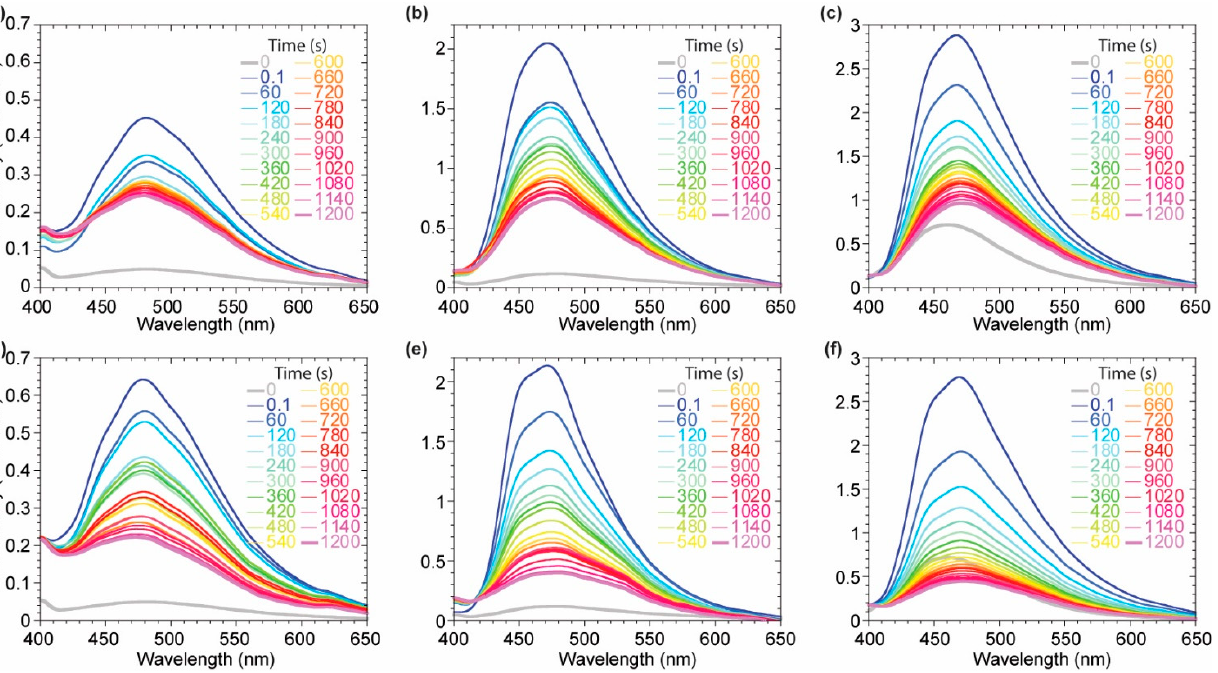
Figure 4. Kinetic experiments in DOPC ( a – c ) and DPPC ( d – f ) for compounds 2 ( a , d ), 3 ( b , e ), 4 ( c , f ). Probes concentration during the measurement: 7.28 × 10 − 7 M for 2 , 3.7 × 10 − 6 M for 3 and 3.4 × 10 − 6 M for 4 .